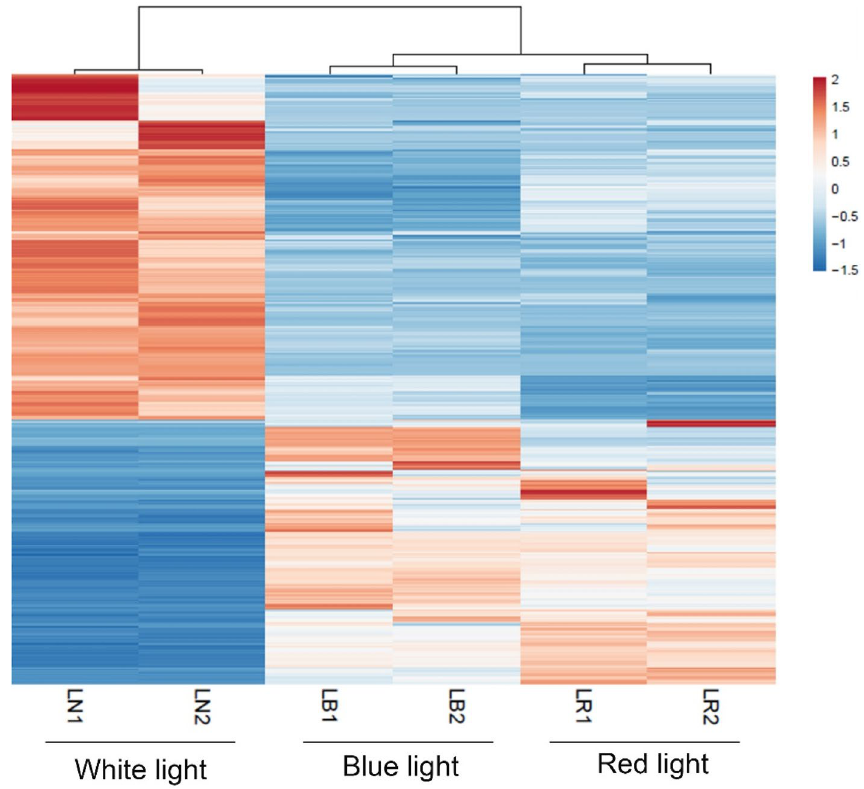
Figure 3. Heatmap representing the expression pattern of transcripts differentially expressed in leaf tissues of plants grown under red light or blue light compared to the ones grown under white light. Hierarchical clustering was performed with the Euclidean distance matrix and average linkage method. Red color indicates higher expression, whereas blue color indicates lower expression of the transcripts. A larger heatmap including transcripts differentially expressed in lettuce plants exposed to red or blue light versus white light is provided in Supplementary Fig. 1. The heatmaps were constructed using the TPM values of the transcripts in ClustVis tool (20th December 2018; https:// biit. cs. ut. ee/ clust vis/) by Euclidean distance matrix and average linkage method 38